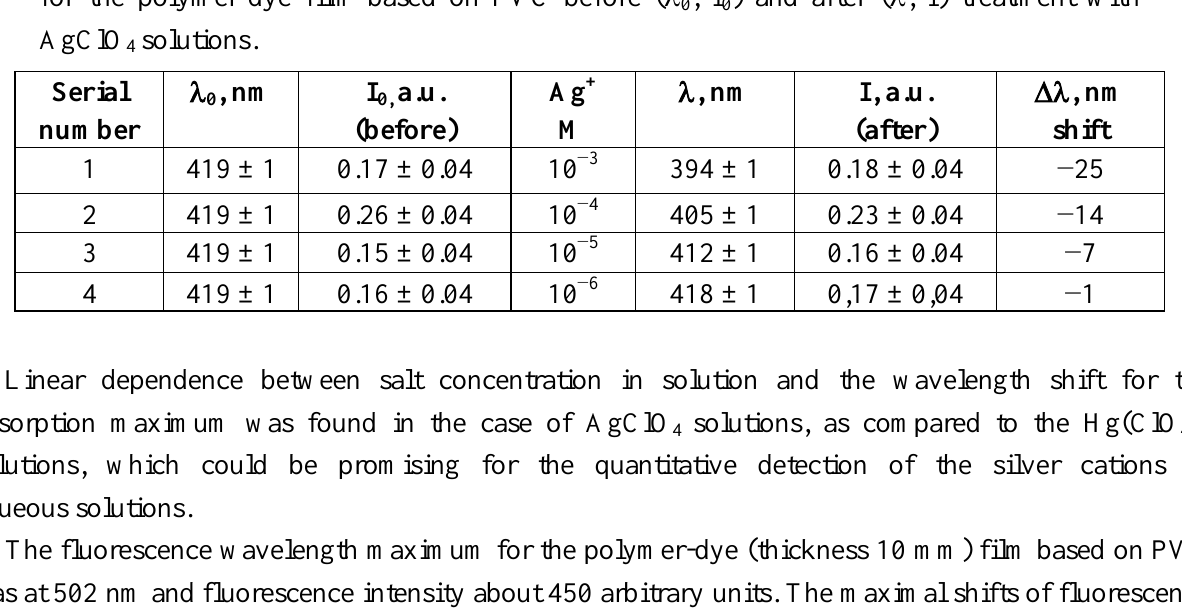
, I ) and after (  , I) treatment with 0 0